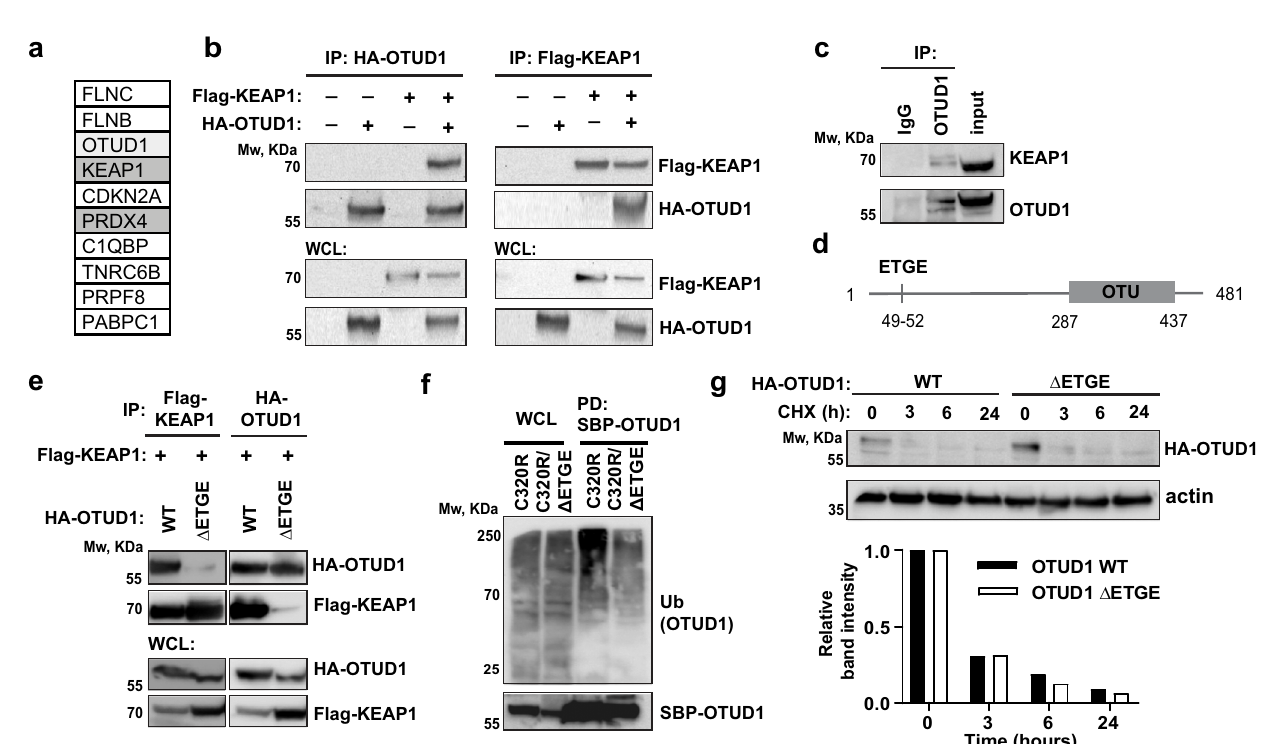
Fig. 3 | OTUD1 enhances myeloma sensitivity to PIs. a , b The total amount of ubiquitinated proteins in whole cell lysates from OTUD1 oe (a), and sh OTUD1 (b) MM cells was analyzed by western blotting. c , d The amount of spliced and unspliced form of XBP1 mRNA was measured by RT-PCR. Signi fi cance was com- paredusingthetwo-tailedStudent ’ sttest.(in c XBP1s p=0.0025, XBP1up =0.8216; in d XBP1sp =0.0013, XBP1up =0.0821).Dataarerepresentedasmean±SDfrom3 biologicalreplicates. e The totalamount of ubiquitinated proteins in extracts from RPMI8226 OTUD1 oe cells with and without transfection of si control or si IgL. f , g Immunoblot analysisof immunoprecipitated Flag-tagged IgL stably expressedin RPMI8226 cells with OTUD1 oe ( f ) and sh OTUD1 ( g ). h Proteasome capacity was analyzed in RPMI8226 cells with OTUD1 oe and siRNA-targeting IgL using intra- cellular Bodipy fl uorescent probe staining and quanti fi ed by fl ow cytometry.